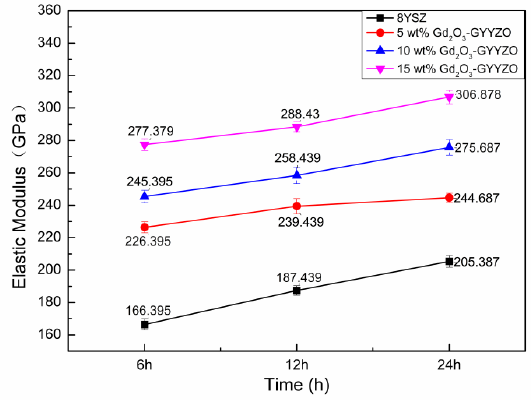
Figure 7. Elastic modulus of the sintered bulks.